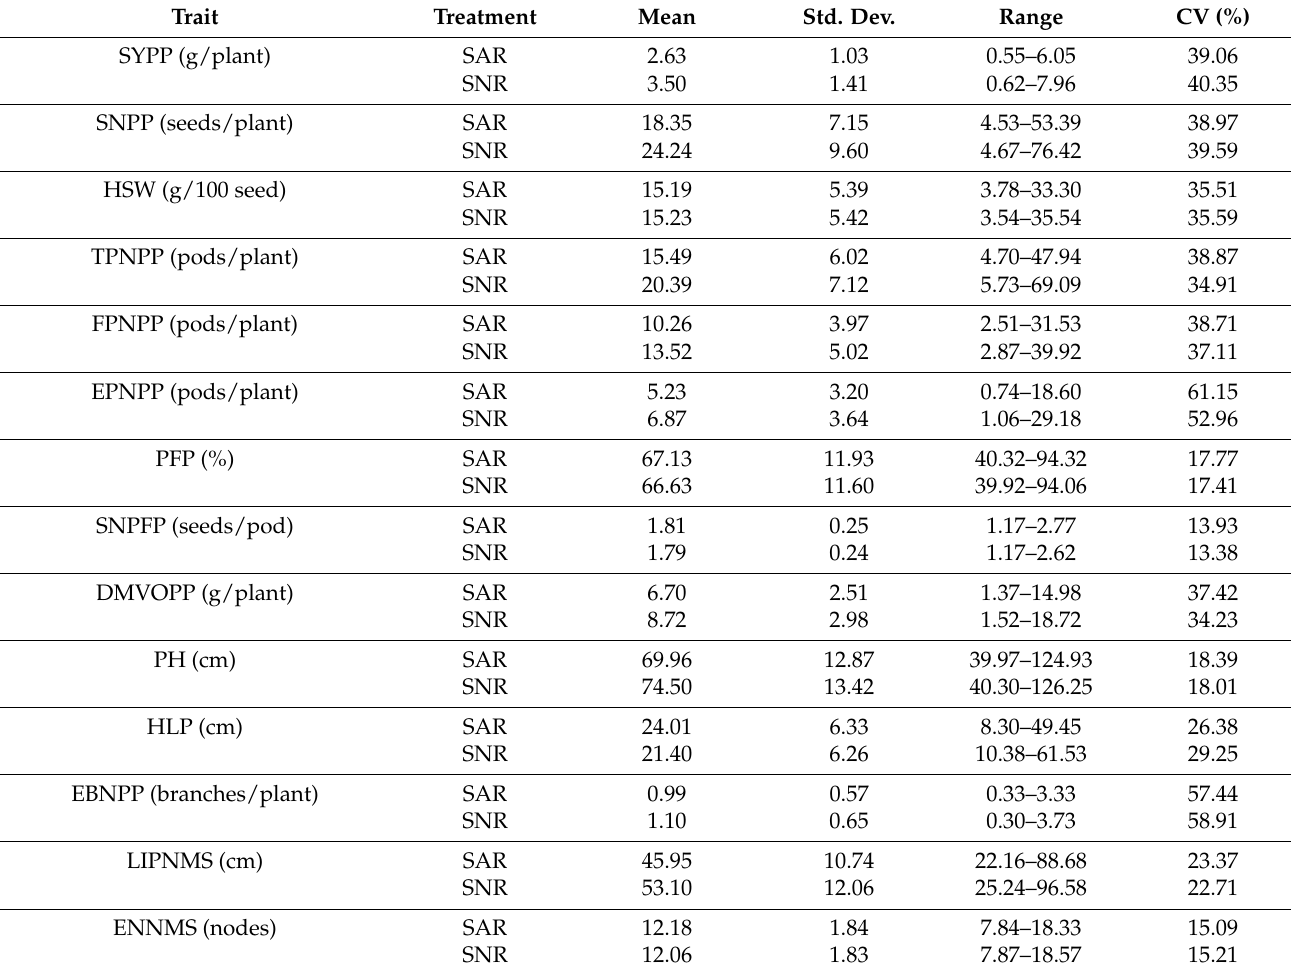
Table 1. Descriptive statistics for the 14 traits potentially related to AR tolerance for the tested soybean population under the two simulated rain